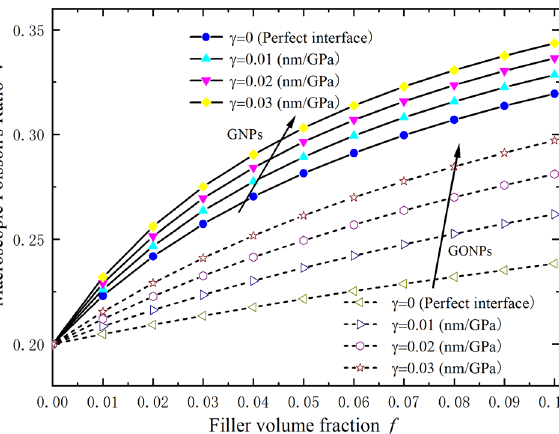
Figure 7: The normalized equivalent stress – strain curves of the nanoplate composite with the di ff erent sliding parameters under the same fi ller concentration of